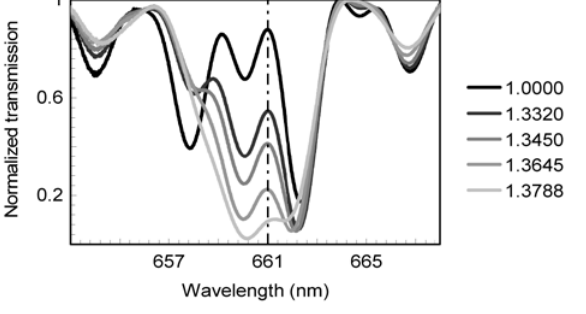
Figure 10. Normalized transmission spectra of the Miniaturized Long-Period Fiber Grating Assisted Surface Plasmon Resonance Sensor